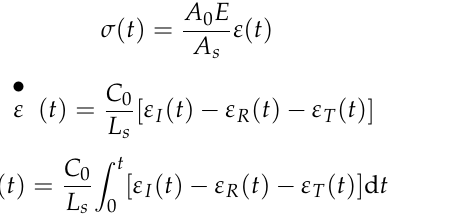
Figure 3. Microscopic test equipment: ( a ) scanning electron microscope and ( b ) X-ray diffraction apparatus.